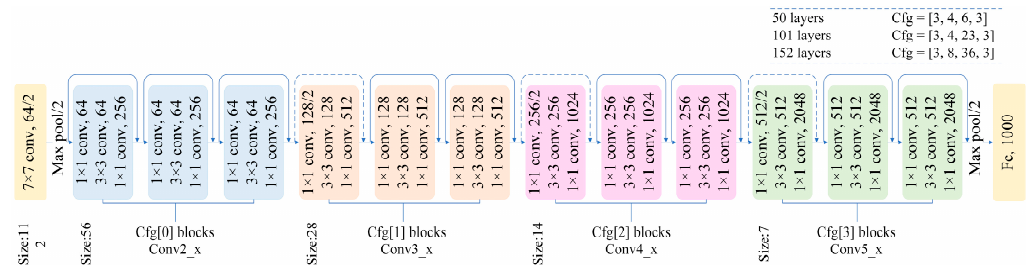
Figure 2. Overall architecture of the residual networks including the ResNet-50, ResNet-101, ResNet-152.